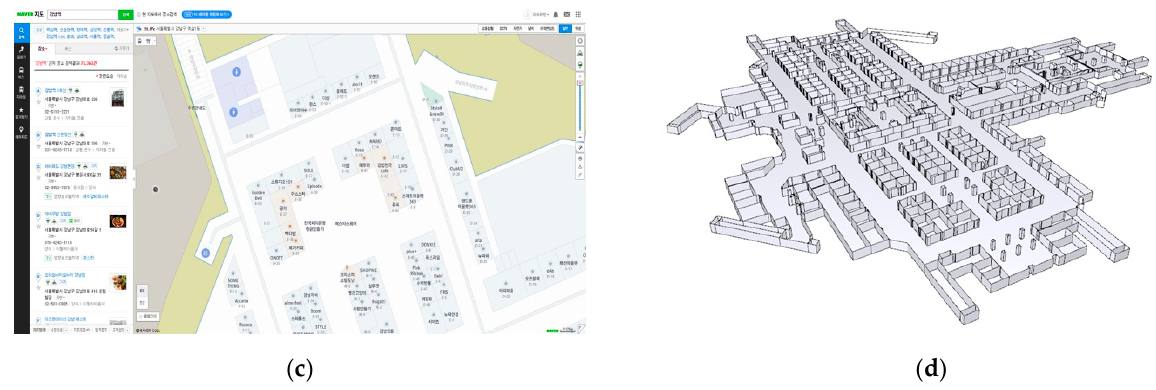
Figure 6. 3D spatial data generation using VWorld data. ( a ) VWorld raw data. ( b ) Store unit object generation. ( c ) Attribute information input. ( d ) 3D modeling (3DS).